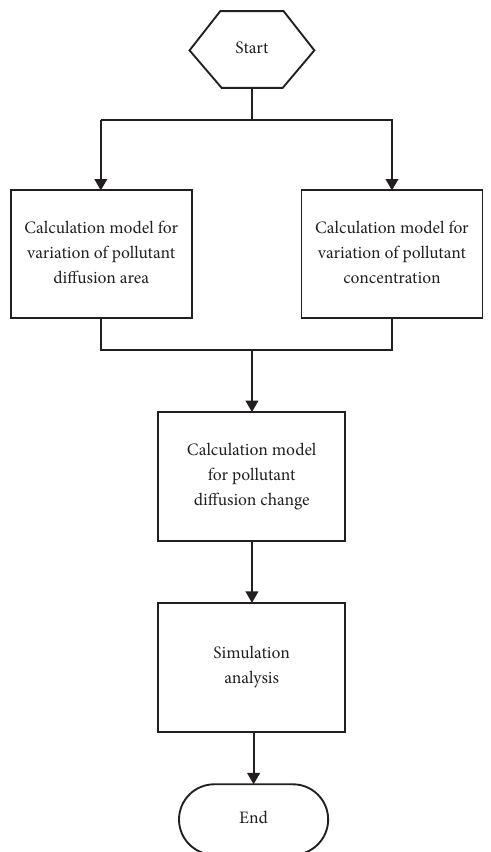
Figure 1: Research thought of the calculation model for cyano- bacterial pollutant diffusion change in Chaohu Lake of